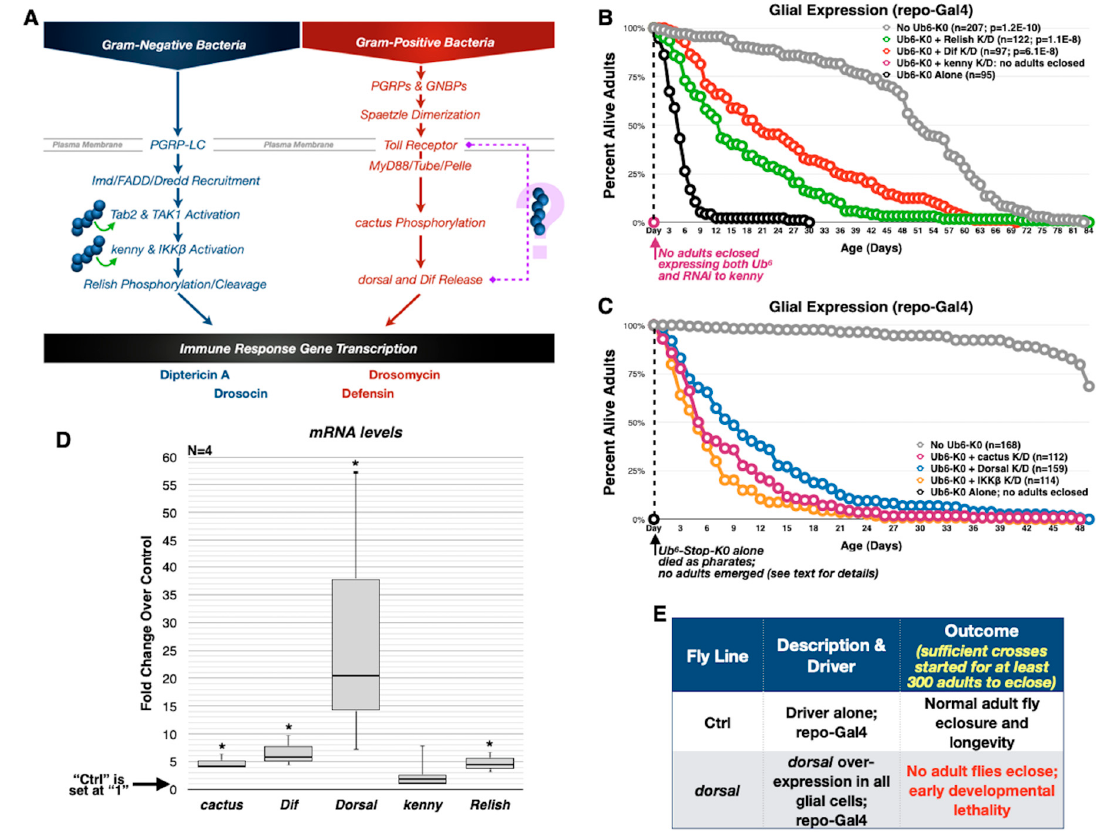
Figure 4. NF-kB pathway dysregulation when lysine-less, untethered hexa-ubiquitin is expressed in fly glia. ( A ) Summary of the IMD (left) and Toll (right) pathways in flies and potential roles for unanchored ubiquitin chains in them. ( B , C ) Longevity of adult flies expressing Ub 6 -Stop-K0 alone or in combination with RNAi-dependent knockdown of the noted NF-kB-related genes in fly glia. ‘ p ’ values are from log-rank tests. Longevity curves in panel B for “No Ub 6 -K0” and “Ub 6 -K0 Alone” are the same as in Figure 2C. Adult flies from experiments with RNAi lines were collected and aged simultaneously and supplement results from earlier set ups where no adults emerged from repo-Gal4 X Ub 6 -Stop-K0 crosses conducted for Figure 2C (all developing flies from those earlier crosses died as pharate adults). ( D ) Box-and-whisker plot of mRNA levels of the noted NF-kB-related genes by qRT-PCR from dissected heads of pharate adults expressing Ub 6 -Stop-K0 in glial cells, presented as fold change over controls. Statistics are from Student’s t -tests comparing levels of each gene from Ub 6 -Stop-K0 flies to “Ctrls” that contained the repo-Gal4 driver on the genetic background of Ub 6 -Stop-K0. Asterisks: p < 0.05. ( E ) Survival outcomes for flies that express exogenous dorsal in glial cells, in the absence of any Ub 6